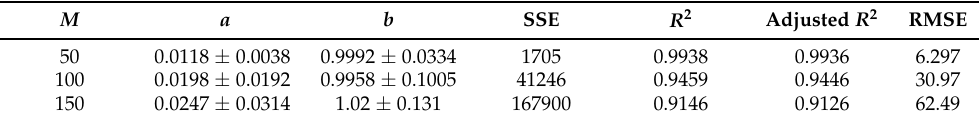
Figure 7. Computational complexity analysis of the proposed ALC_IGA in single thread. Table 5. The exponential curve fitting a · n b of the running time of ALC_IGA with single core while M is set to 50, 100, and